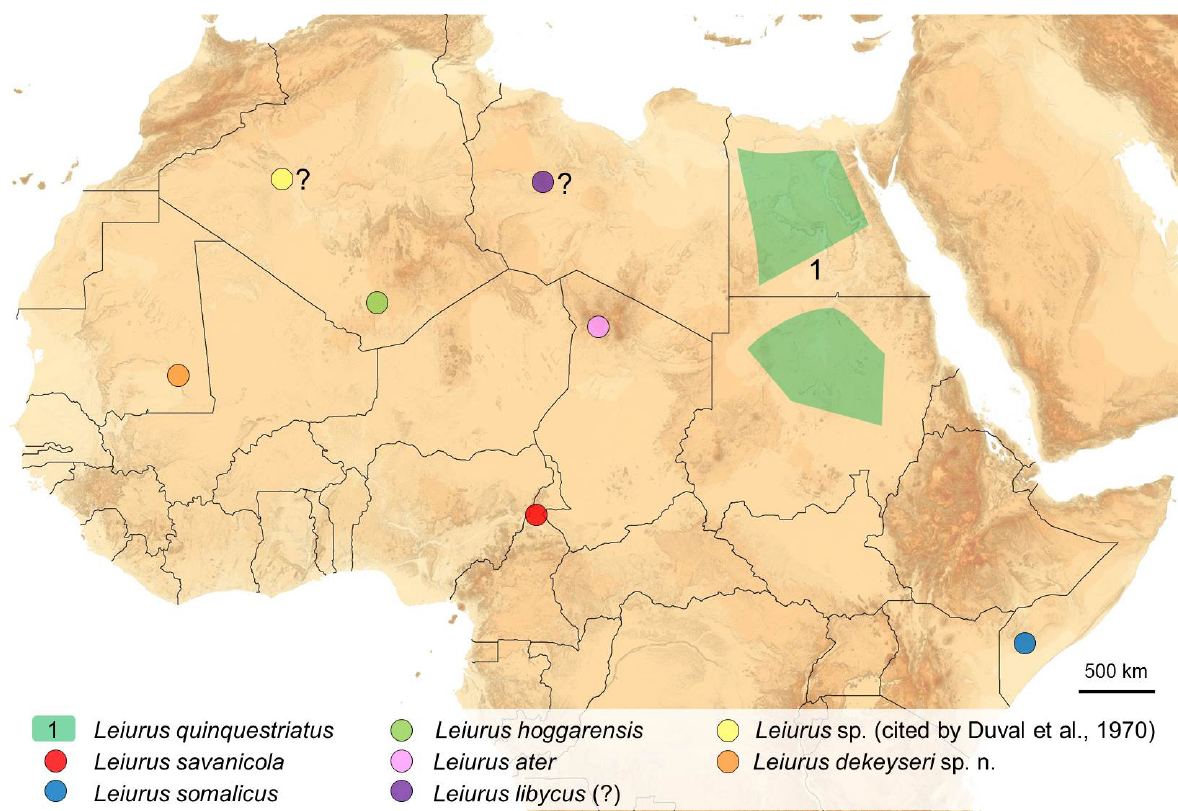
Figure 3. Map of the north portion of Africa showing the distribution of the known Leiurus